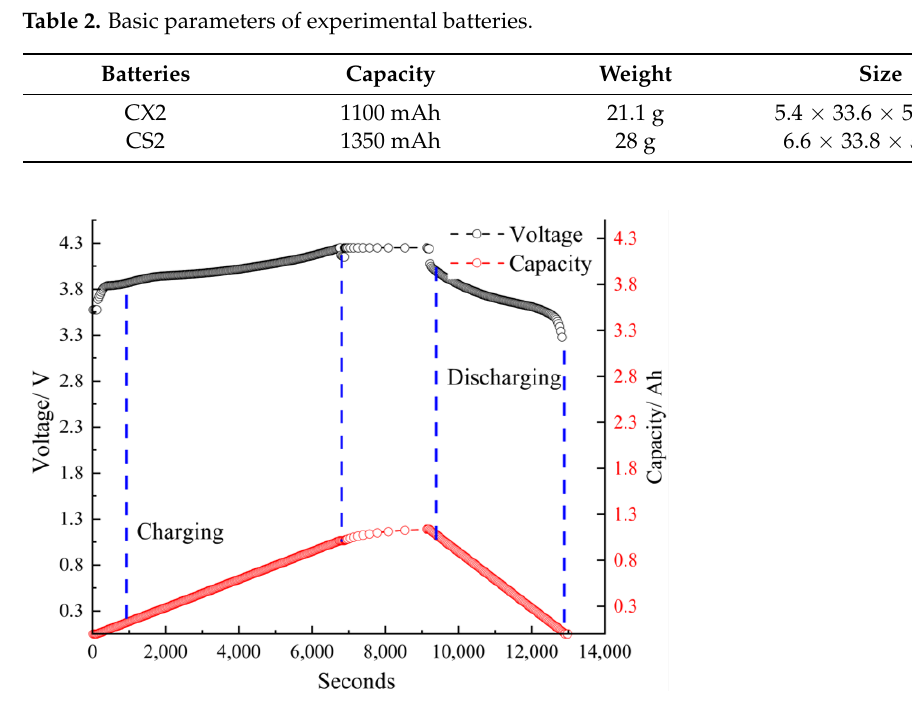
Figure 4. Curve of single voltage and battery capacity over time for one aging